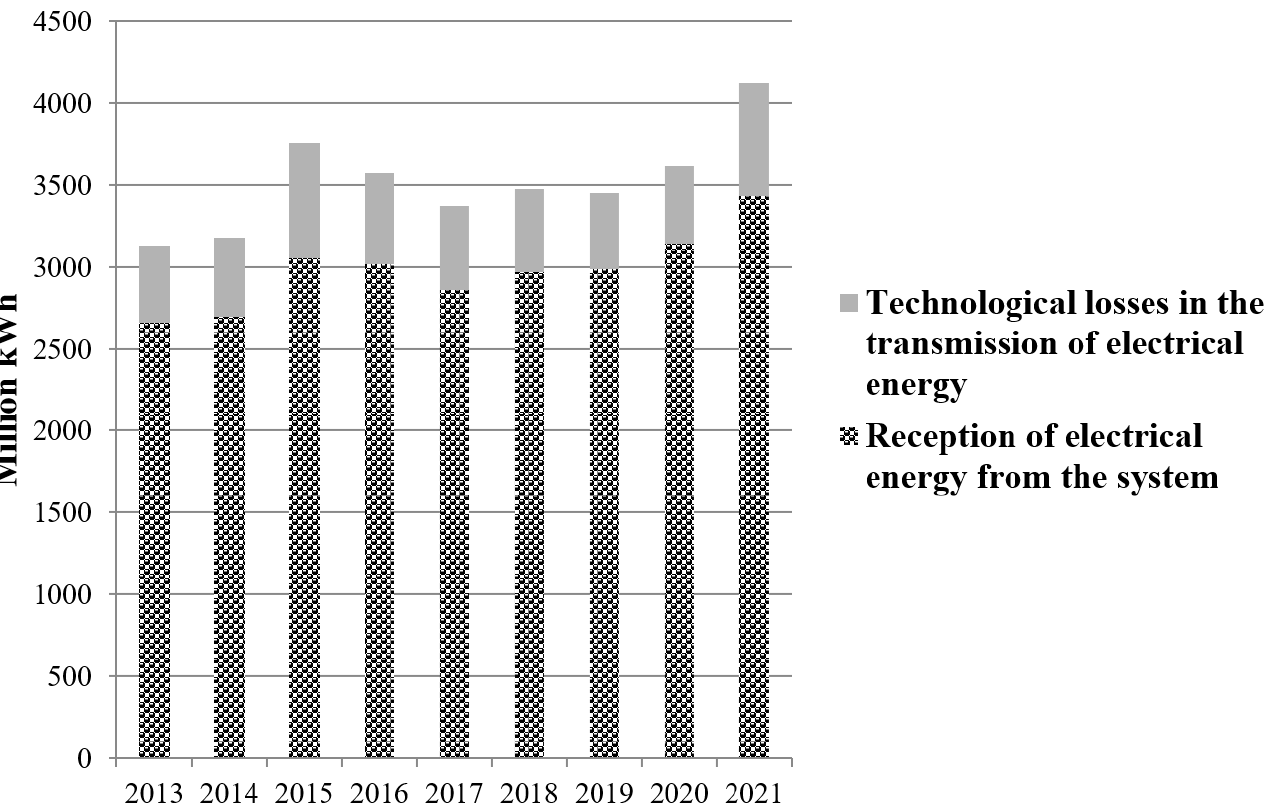
Figure 1. Diagram of changes in the reception of electricity from the system and technological losses during the transmission of electricity for the period of 2013–2021.